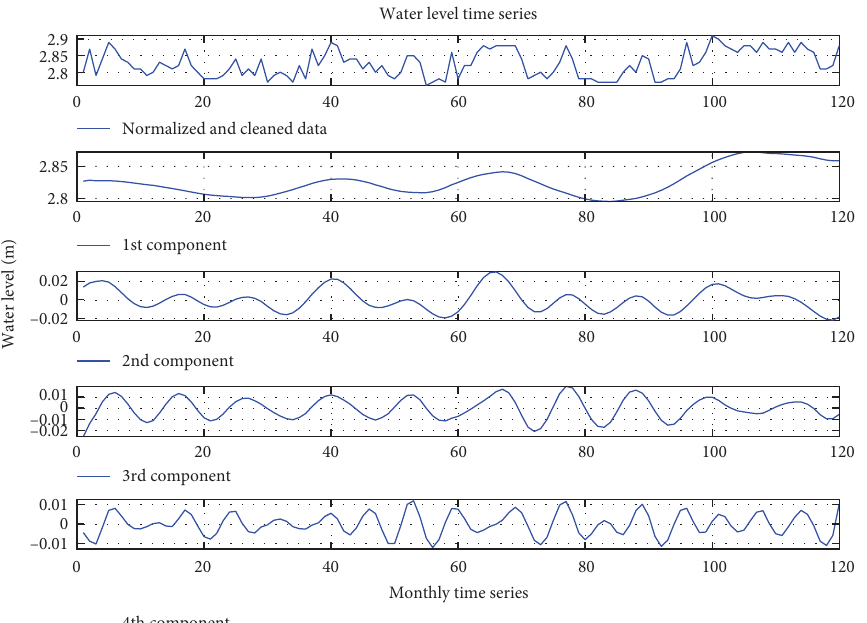
Figure 5: Normalized and clean time series and the 1 st four components obtained by SSA. Table 1: Collinearity statistics to the nominated predictors. Climatic factors Tolerance Water _1 0.721 Dew 0.498 ws 0.420 Table 2: The correlation coefficients between independent and dependent factors. Data WL t-1 DF WS Raw 0.643 ∗∗ 0.378 ∗∗ − 0.026 Preprocessed 0.993 ∗∗ 0.457 ∗∗ − 0.555 ∗∗ ∗∗ Correlation is significant at the 0.01 level